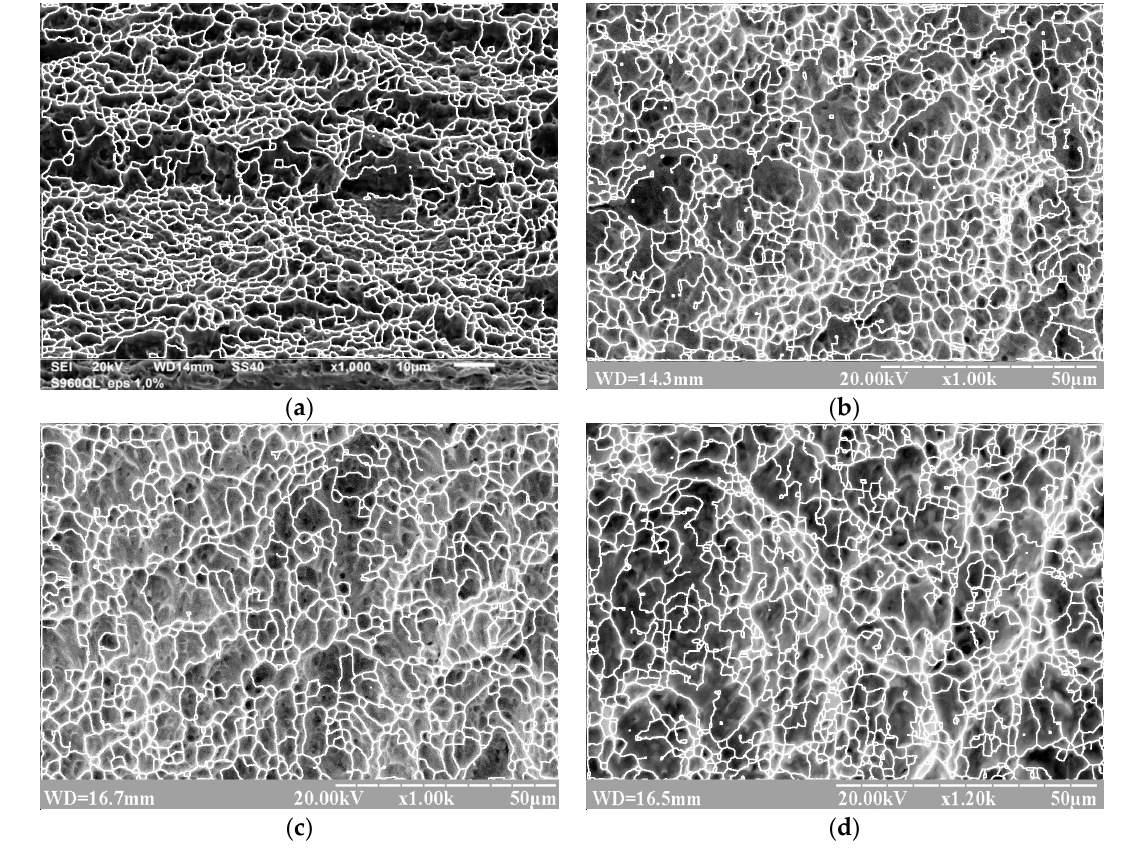
Figure 3. The result of recognizing the edges of dimples of ductile tearing on fracture surface of specimens from alloys VT23 ( а ) and VT23 М ( b – d ) under static ( а , b ) and impact ( с , d ) loading. After that, the connected areas of pixels surrounded by previously found edges were selected.